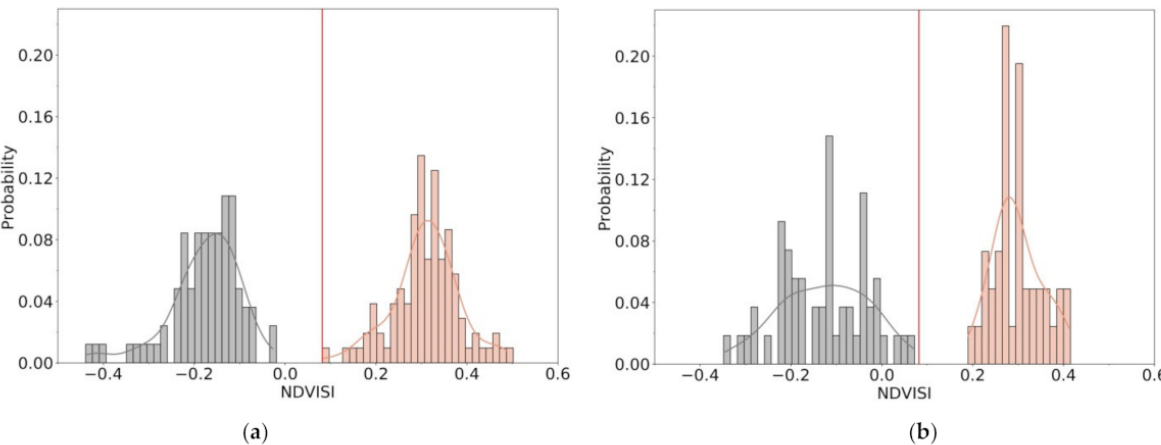
Figure 7. The frequency histograms of minNDVISI values distribution of bare soil (grey colour) and grassland (red colour) classes: ( a ) sample points; ( b ) control